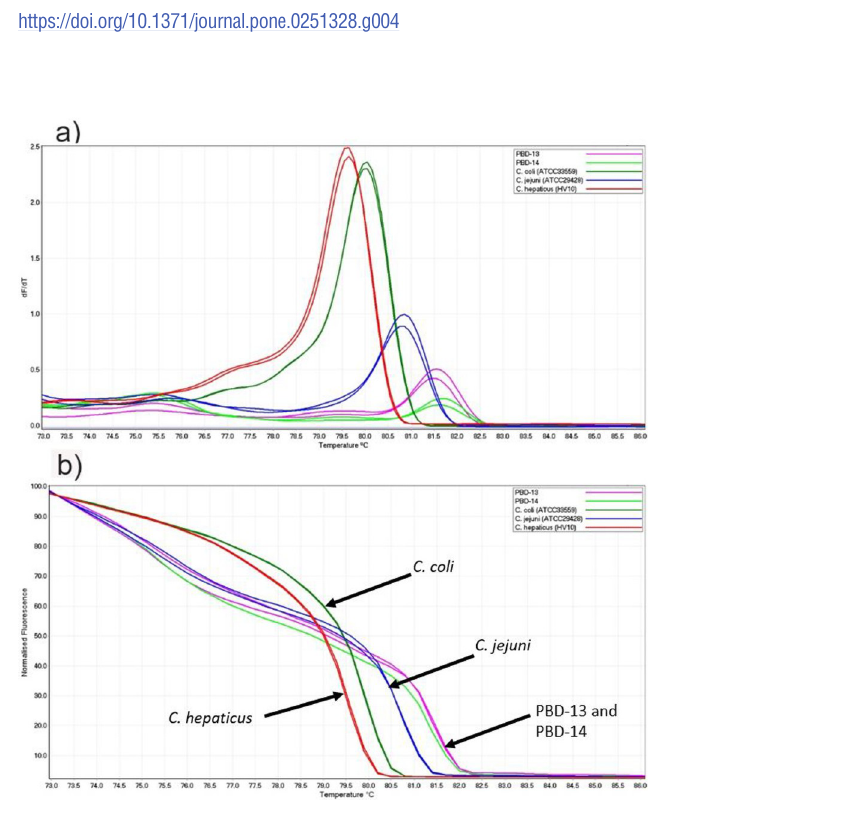
PLOS ONE | https://doi.org/10.1371/journal.pone.0251328 May 13,